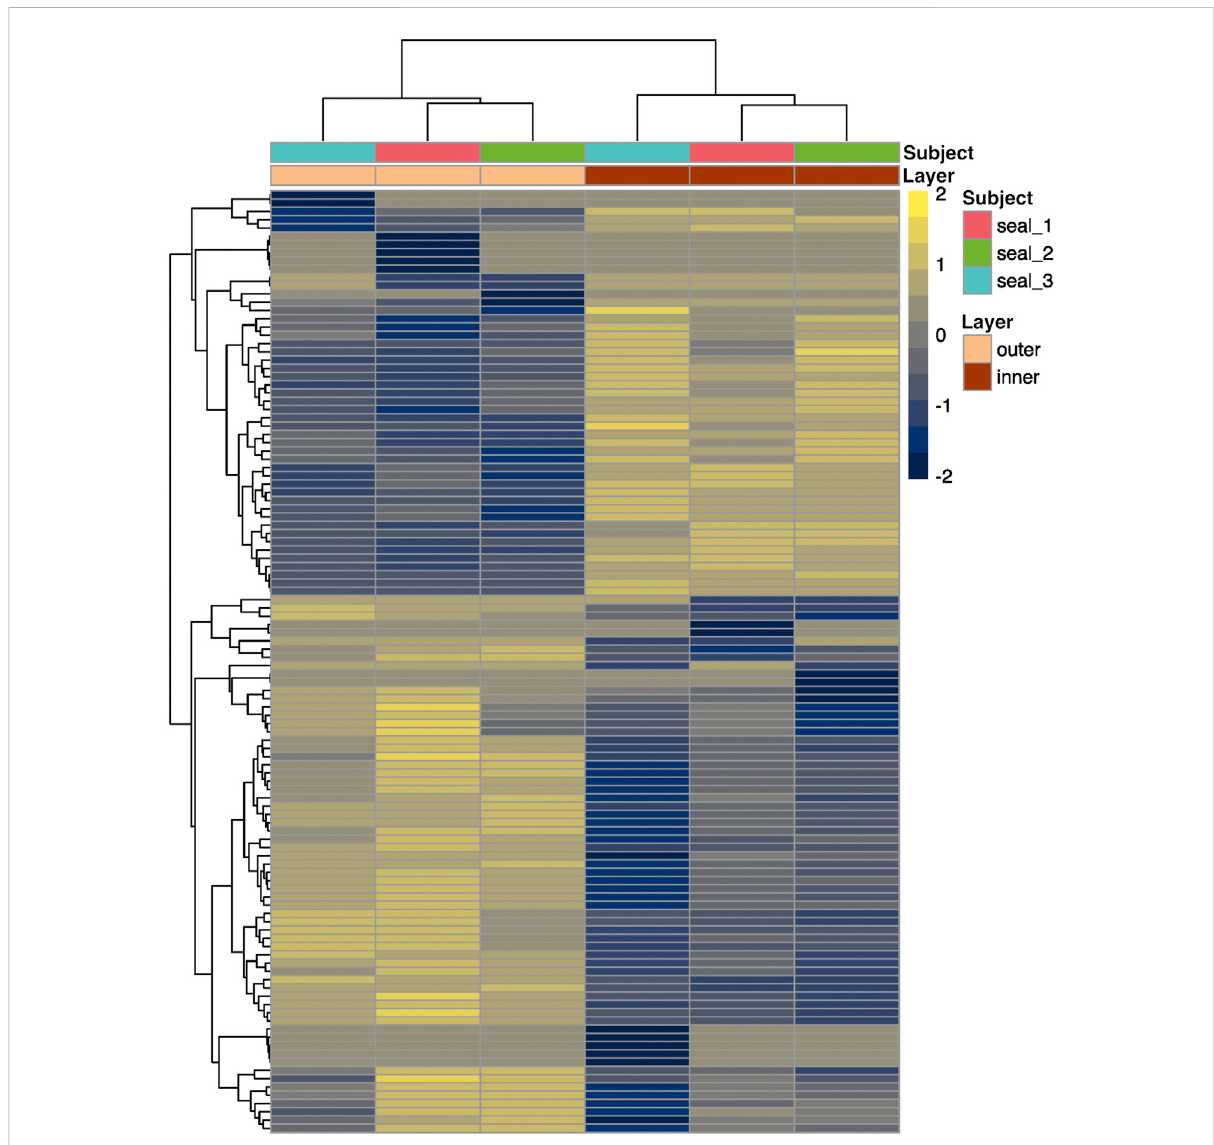
FIGURE 4 Heatmap showing scaled relative expression levels (transcripts per million, or TPM) of 61 annotated genes that were differentially expressed between inner and outer layers of blubber in juvenile northern elephant seals ( n = 3). Genes with higher expression in inner blubber are shown in yellow, while those with higher expression in outer blubber are shown in blue. Rows and columns were clustered by expression similarity (Euclidean